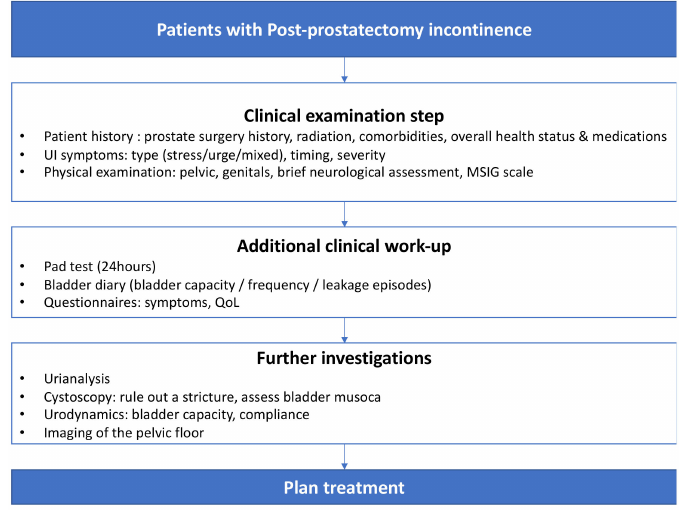
Figure 1. Diagnostic flowchart for patients with